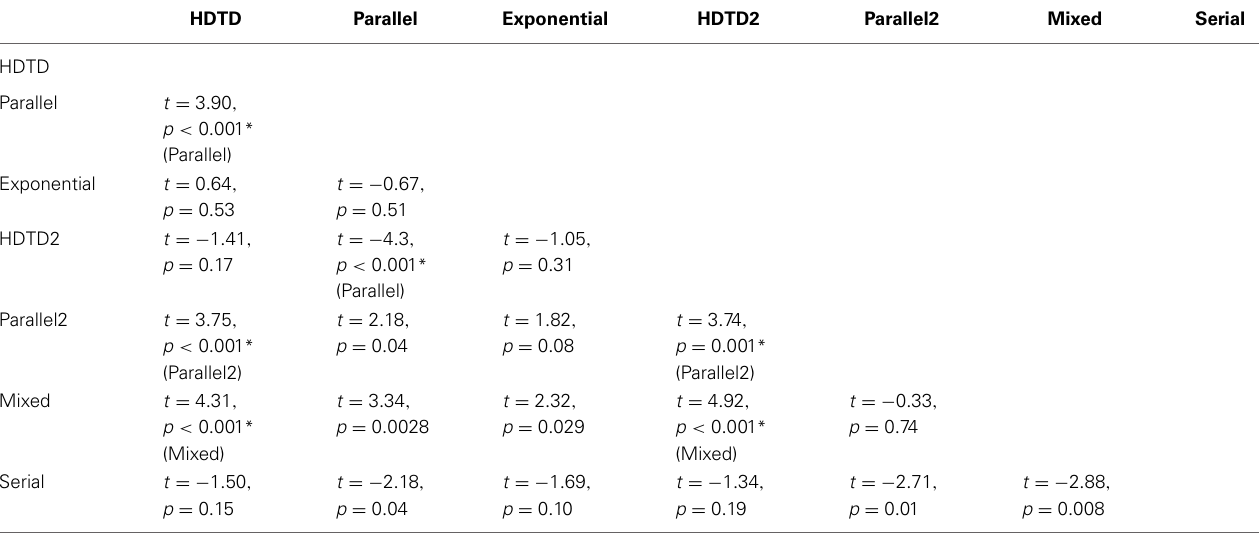
Table 2 | Pairwise comparisons between models based on BIC